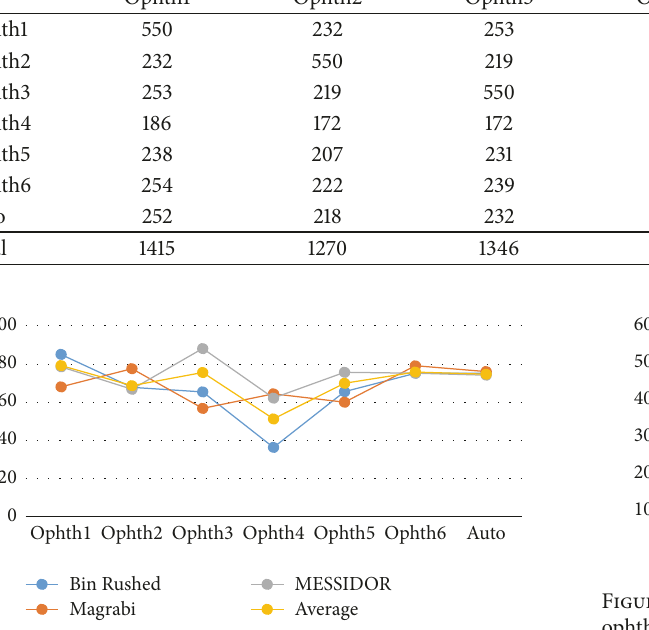
Figure 10: The percentage accuracy of the VCDR for the three images set individually.